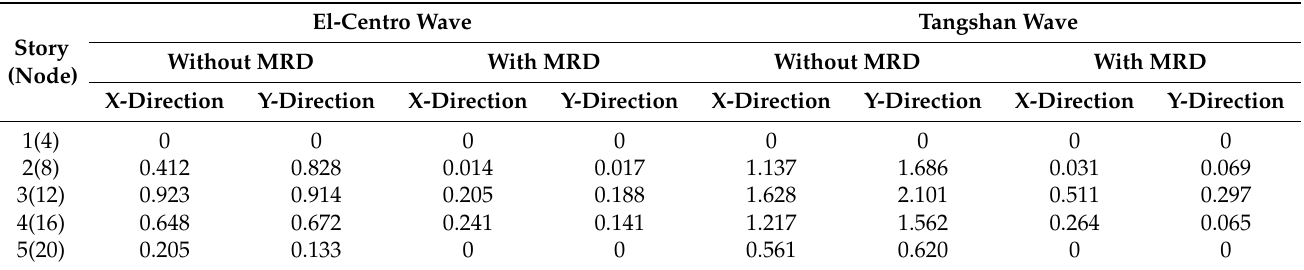
Table 2. The maximum residual displacement angle of column bottom of RC frame structure under seismic wave (rad × 10 − 3